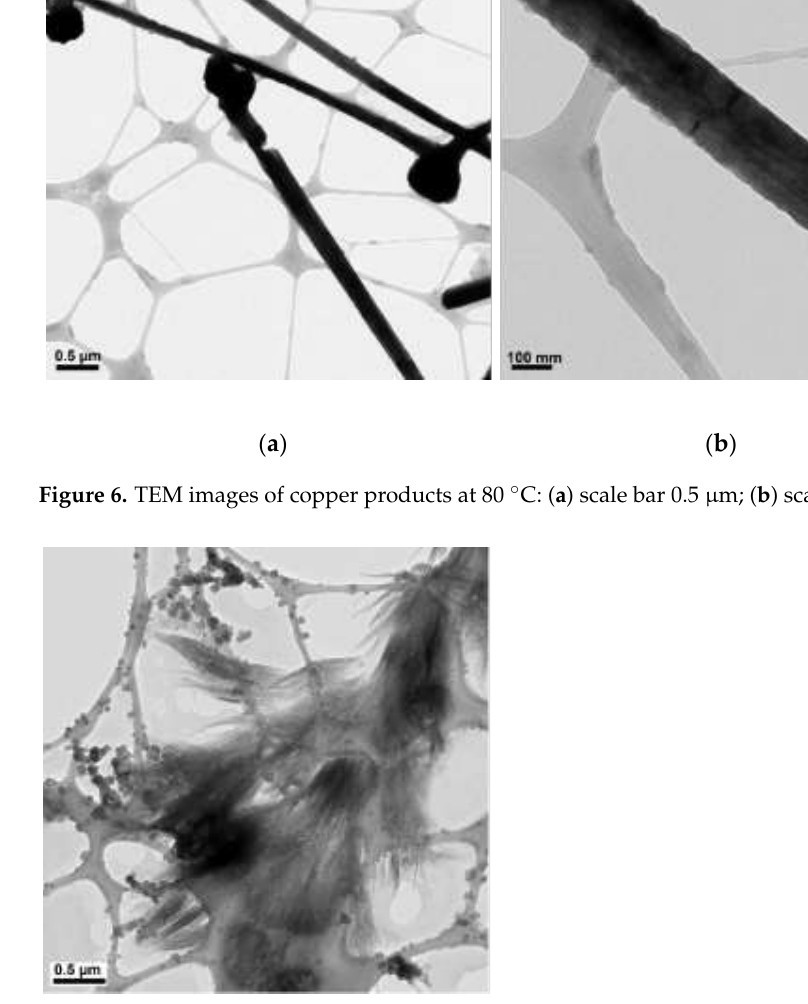
Figure 7. TEM images of copper products at 90 ° C (scale bar 0.5 µm). Table 2. Dimensions of copper products synthesized at various reaction temperatures.